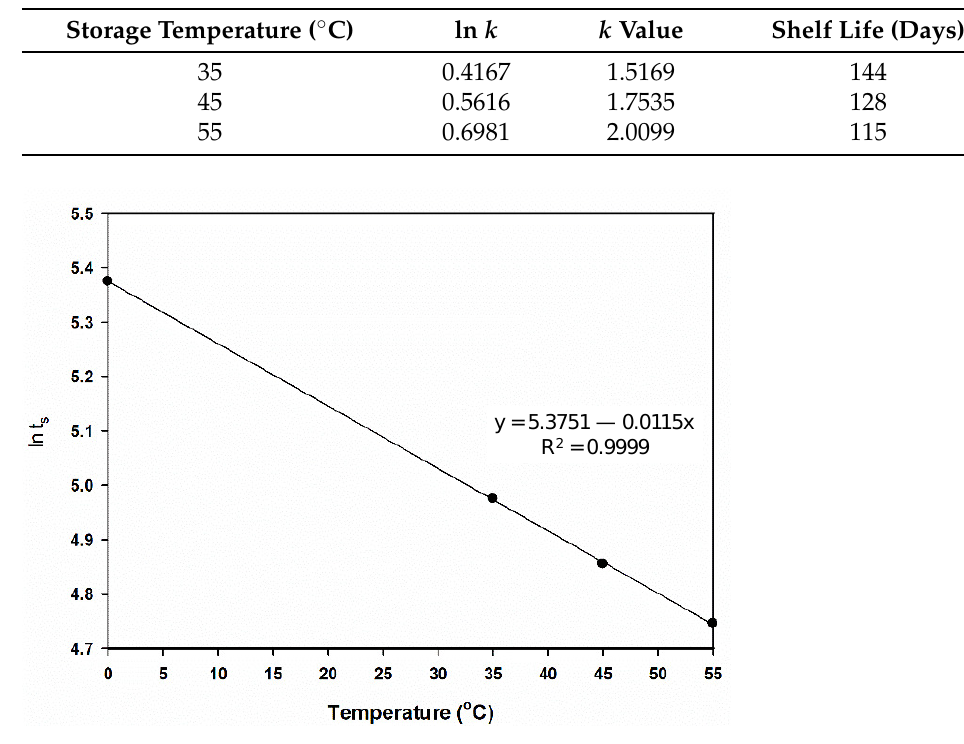
Figure 2. The relationship between shelf life and storage